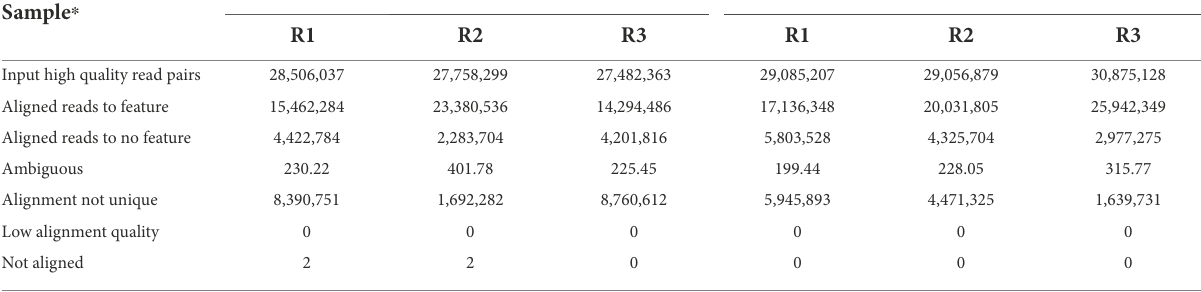
TABLE 3 Statistics of RNA-Seq data from six samples of oil palm plants subjected to two treatments (control and drought stress); three replicates per treatment. Control treatment Sample *